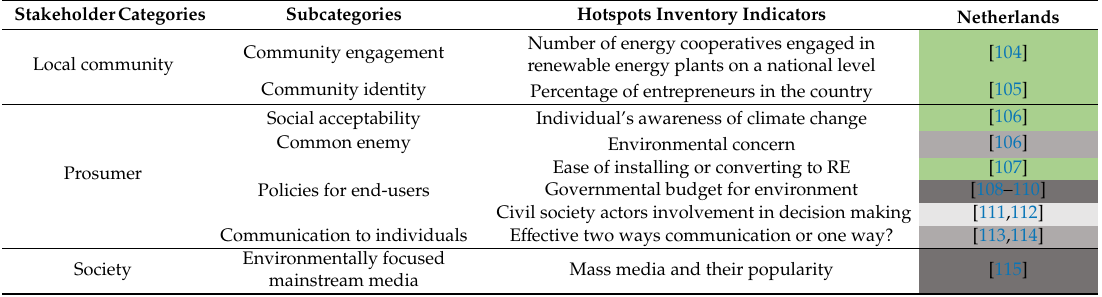
Table 6. Social performance based on the scoring scheme of Figure 2 of the Dutch energy sector with developed S-LCA hotspot